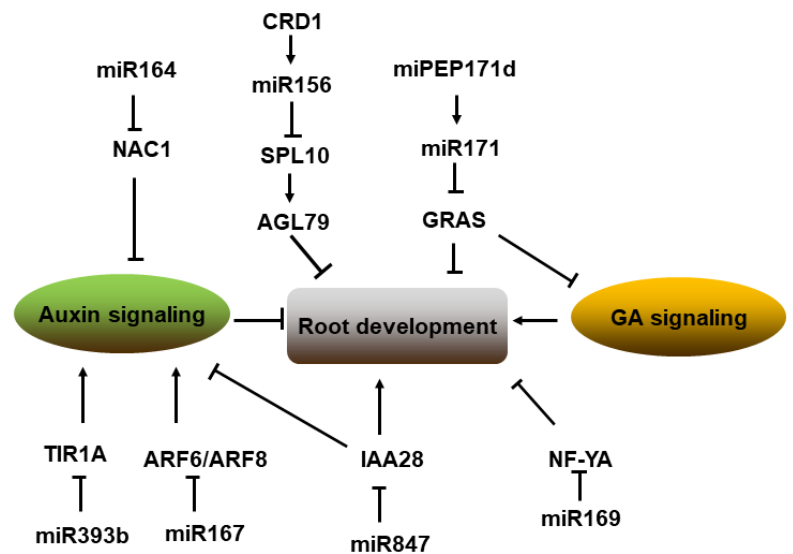
Figure 5. Pathway of miRNAs involved in root development of plant. MiR164, miR167, miR393, and miR171 targeted transcription factors regulate root development through auxin and the GA signaling pathway. MiR156, miR847, and miR169 also participate in regulating root development by targeting special transcription factors. Note: → represents positive regulation, and ┤ represents nega- tive regulation.